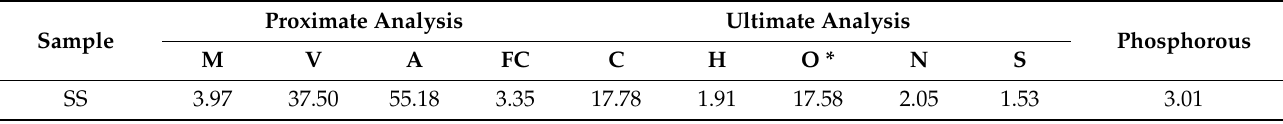
Table 1. Proximate and ultimate analysis of sewage sludge (mass%).